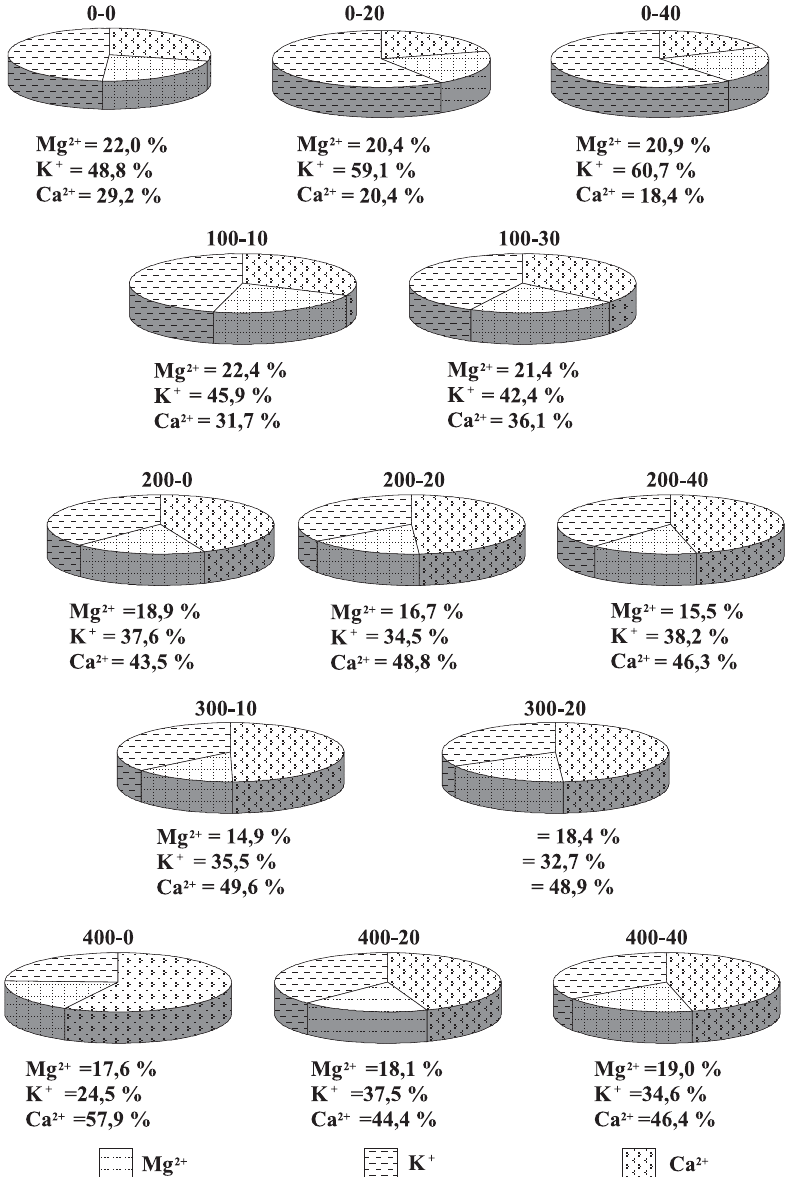
Figura 6. Proporções de potássio K + , Ca 2+ e Mg 2+ no teor total (mmol parte aérea do capim-marandu, no terceiro corte, em função das 13 combinações de doses de N e de